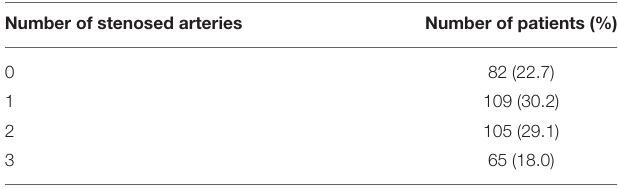
TABLE 1 | Repartition of patients by number of stenosed arteries, regardless of stenosis severity.